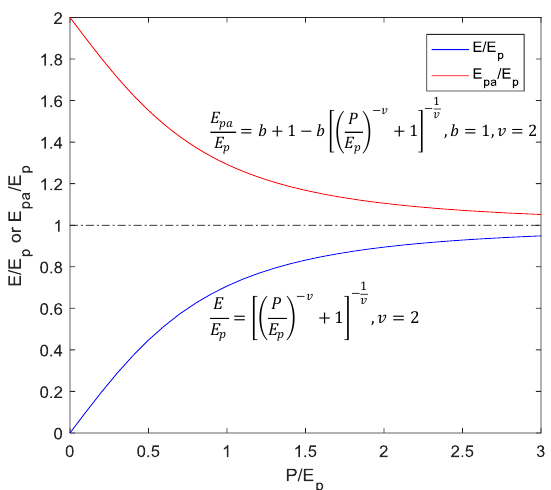
Figure 2. Dimensionless Bouchet–Budyko curves in the normalized complementary